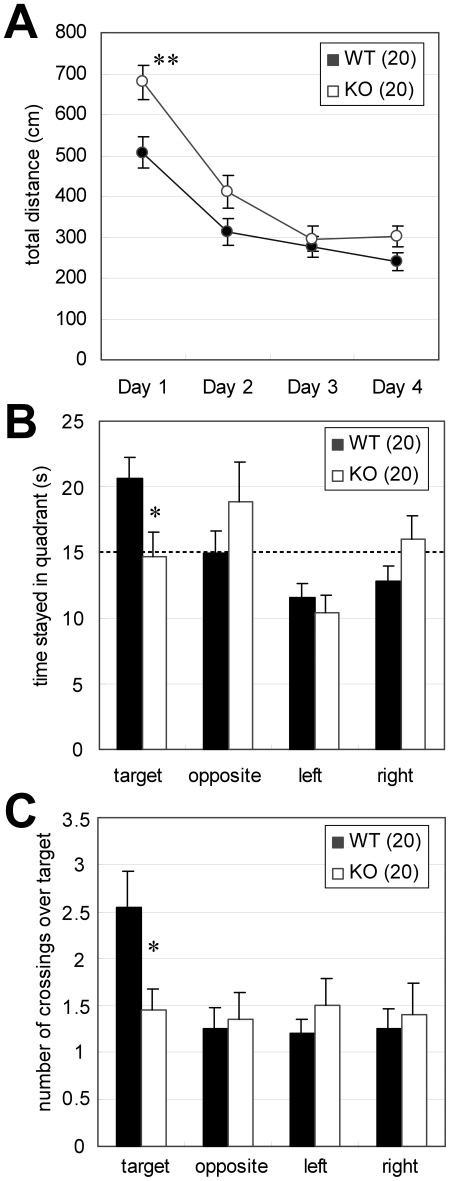
Spatial memory deficits in Lrrtm1 KO mice.(A) Morris water maze training session. The total distance swum before reaching the target was significantly greater in KO mice than in WT mice on the first day, whereas it was comparable to that in WT mice on the second to fourth days. Values are presented as means ±SEM. * P<0.05; ** P<0.01. (B, C) Morris water maze probe test. Both the time spent in the target quadrant (B) and the number of crossings over the targets (C) were lower in Lrrtm1 KO mice than in WT mice. Dotted line indicates the chance level. Values are presented as means ±SEM. * P<0.05 in U-test.